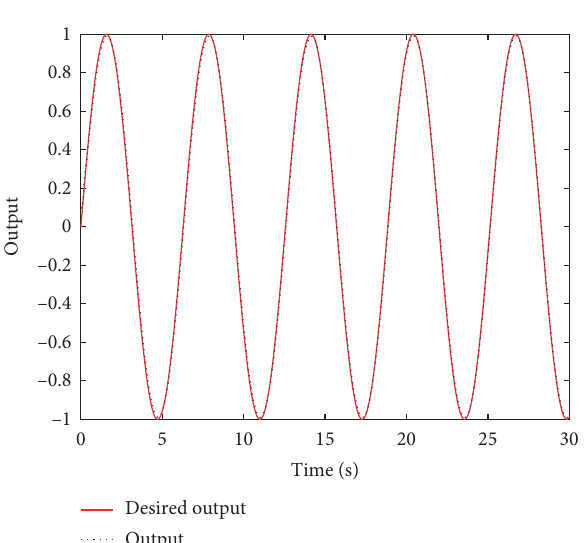
Figure 7: The estimation of x